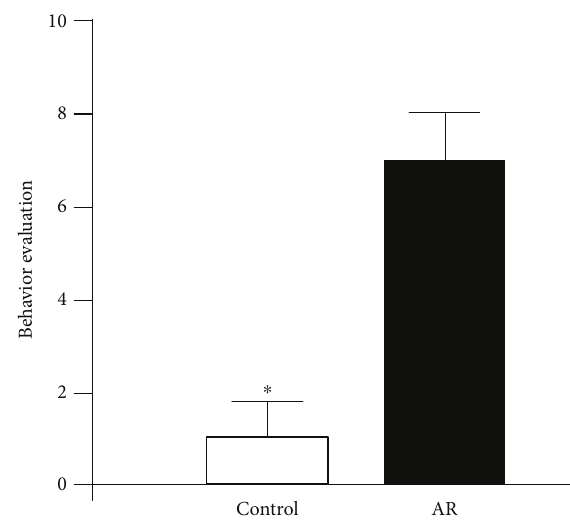
Figure 1: Behavior evaluation between the AR model group and the control group of animals. The total scores in AR model group were greater than 5 ( > 5), which suggested successful establishment of AR. Data are expressed as mean ± SD; ∗ P < 0 01 . Table 1: Serum levels of sIgE, IFN- γ , and IL-4.